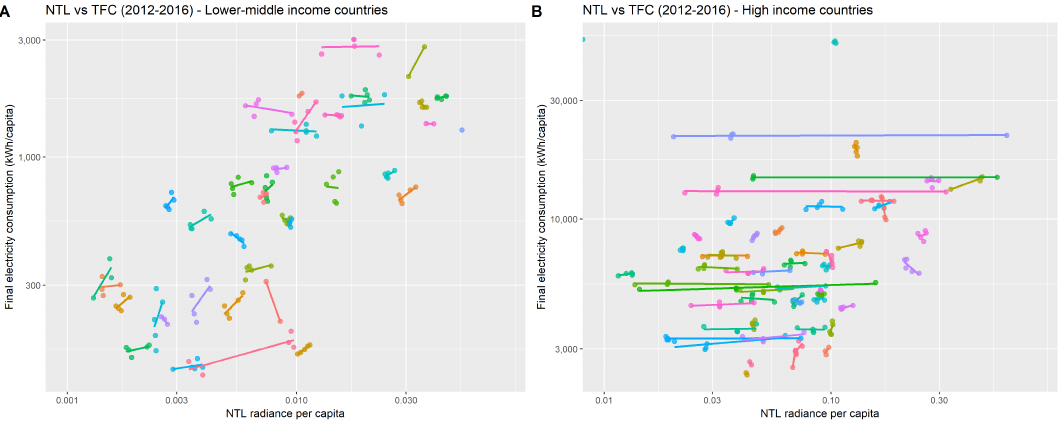
Figure 4. NTL vs. TFC for ( A ) lower-middle income and ( B ) high-income countries (annual values between 2012–2016). Each color represents a separate